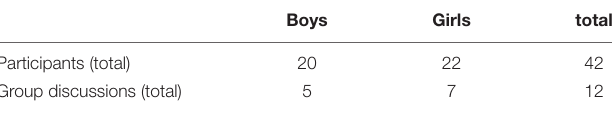
TABLE 1 | Number of participants and group